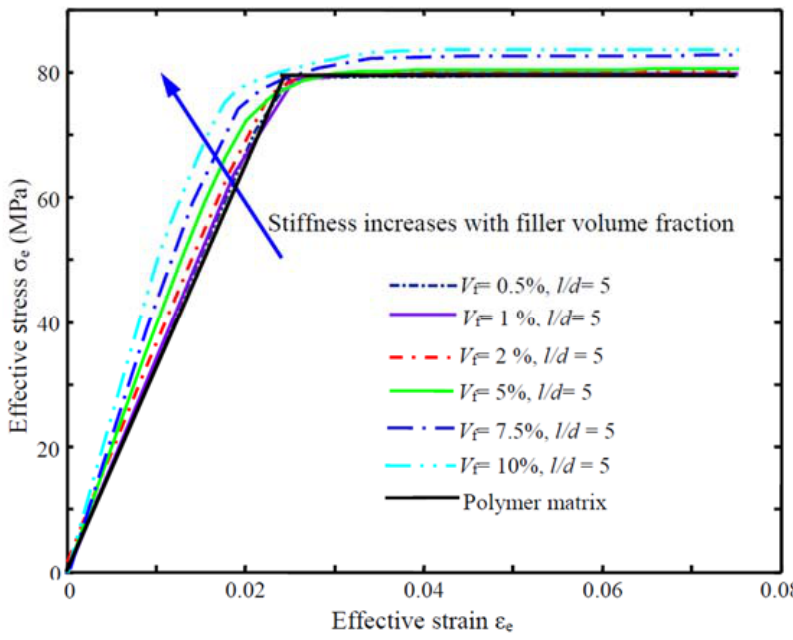
Figure 8. Effective stress-strain diagram σ e - ε e of the PNCs with the clay-particle aspect ratio ρ = 5 (plane-strain, case I).